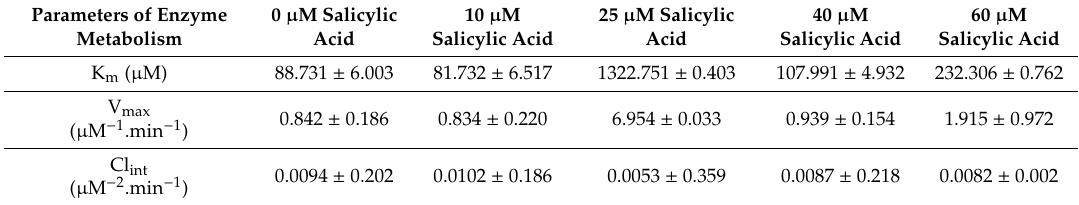
Table 9. Calculated parameters of enzyme metabolism for the in vitro CYP2E1 inhibition study. Parameters of Enzyme 0 µ M Salicylic Metabolism